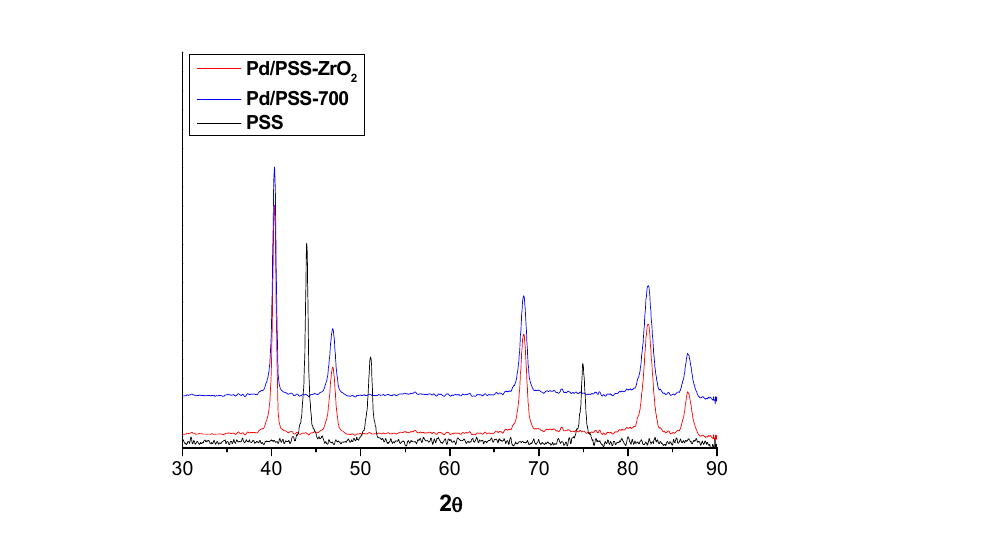
Figure 5. XRD patterns of bare PSS, Pd/PSS-700, and Pd/PSS-ZrO 2 membranes.